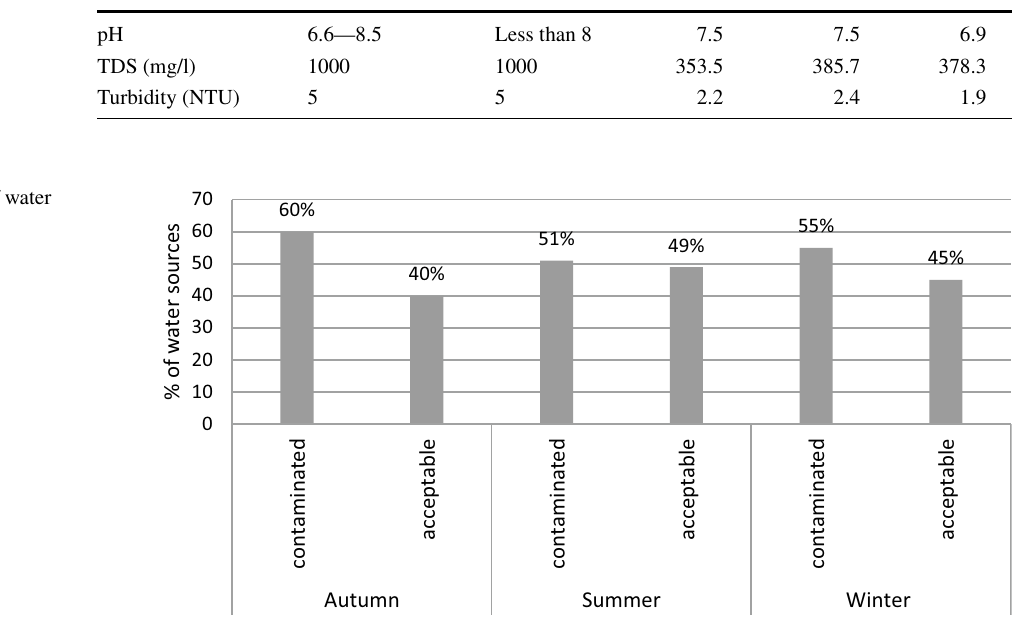
Table 3 Physical characteristics of water samples